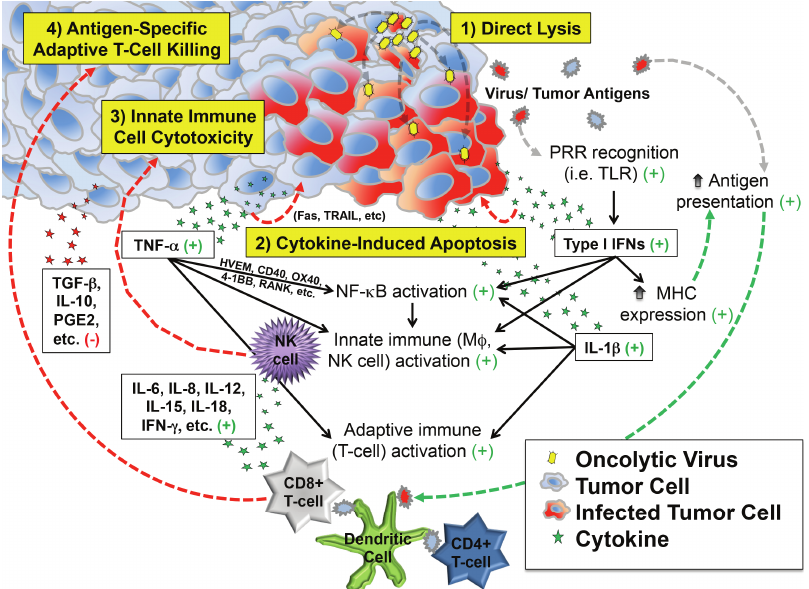
Figure 1. Depiction of critical events beyond infection that contribute to antitumor efficacy of virotherapy. In addition to direct lysis of tumor cells, infection induces secretion of cytokines and chemokines that can kill cancer cells directly and also recruit and activate innate and adaptive immune cells that attack the tumor. Most of the downstream effects of infection are favorable for tumor therapy (indicated by the green plus signs), which counteract immunosuppressive molecules (red minus sign) in the tumor microenvironment.